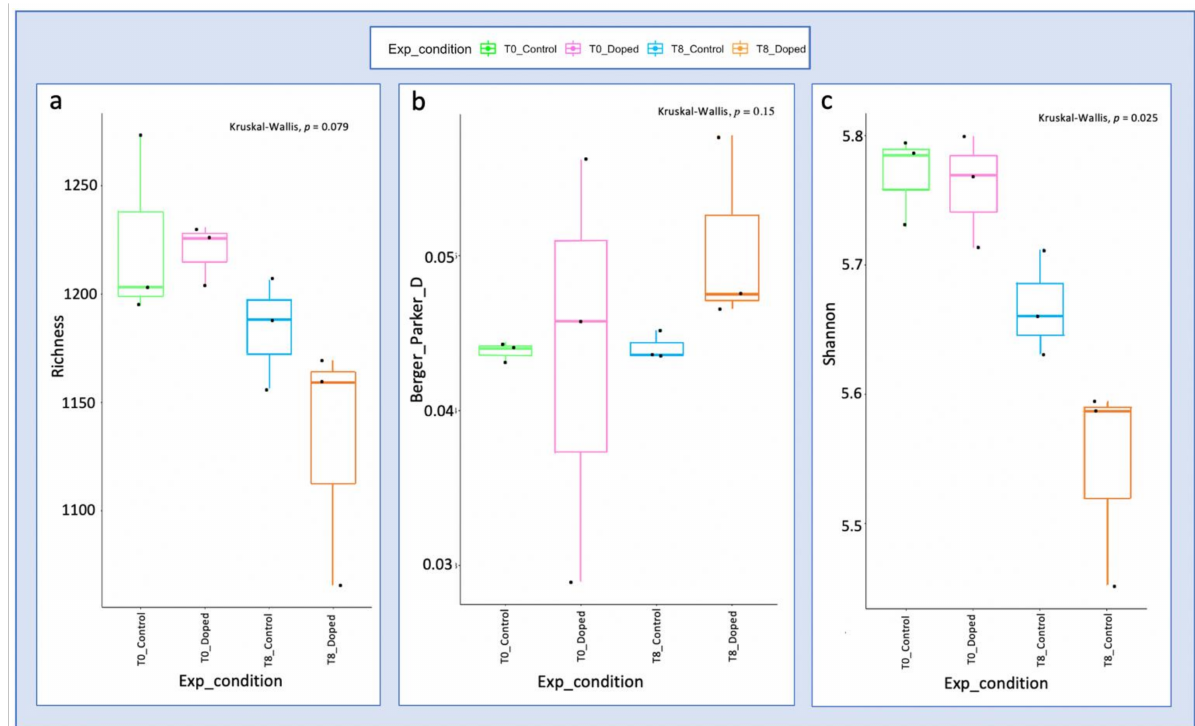
Figure 8. Alfa diversity index of the microbial community in the different CWs systems, irrigated for eight weeks with Ribeira de Joane water not doped (control) or doped with PCP. Samples collected at the beginning (T0) and at the end of the experiment (T8) ( n = 3). ( a ) Richness (number of observed OTUs); ( b ) dominance (Berger–Parker index); ( c ) diversity (Shannon diversity